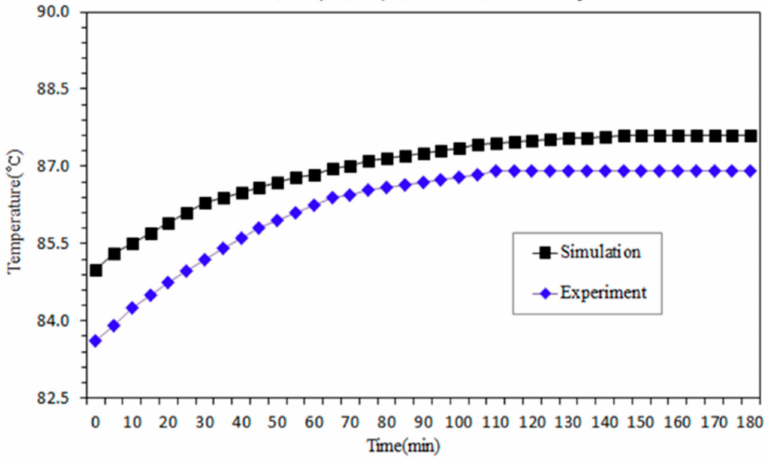
Figure 9. Temperature test results for optimization